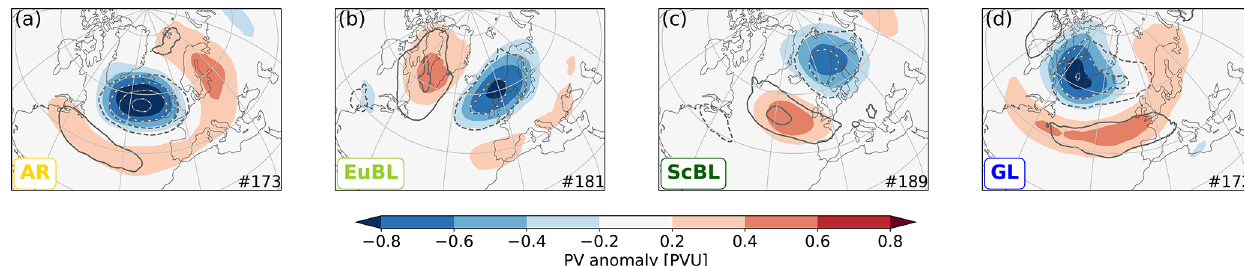
Figure 1. Year-round regime pattern in terms of PV on isentropic levels of blocked weather regimes: (a) Atlantic ridge (AR), (b) European blocking (EuBL), (c) Scandinavian blocking (ScBL), and (d) Greenland blocking (GL). Shading defines the PV regime pattern as composite of all days within a regime life cycle. Contours indicate the composite regime pattern at onset (with a 0.2PVU contour interval). The isentropic levels underlying these composites undergo seasonal variation as given in Sect.